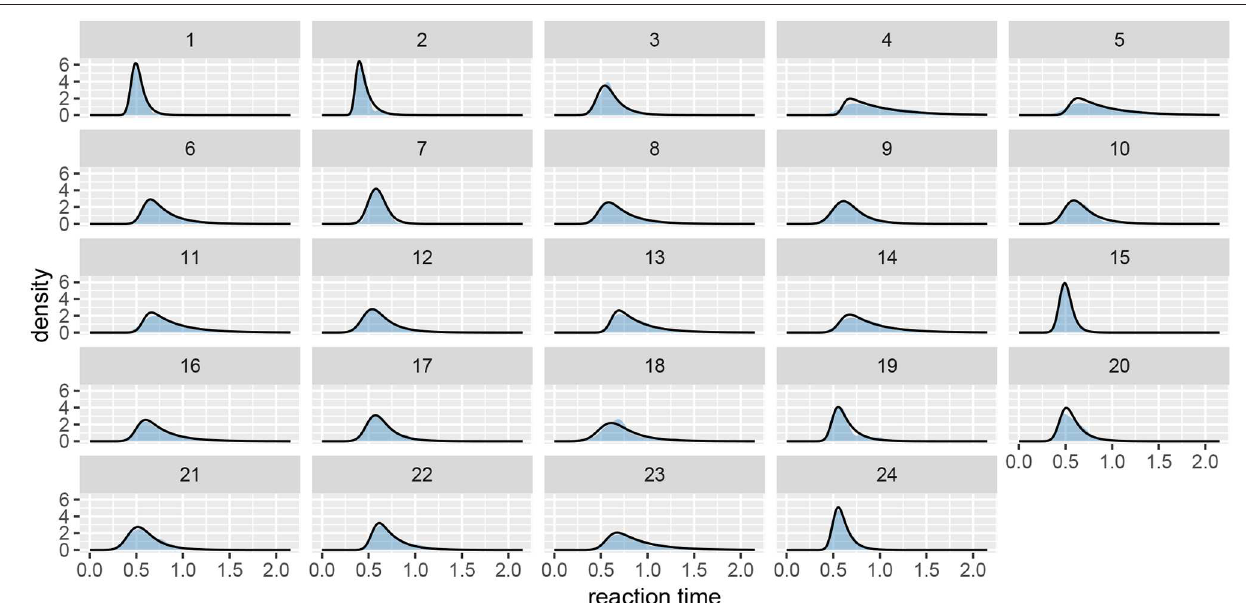
FIGURE 7 | The fit plot for the rt_control_fit . The data are visualized as a blue region while the fit is visualized with a black line. In this case the model fits the underlying data well, similar conclusions can be reached for the test group ( rt_test_fit ).